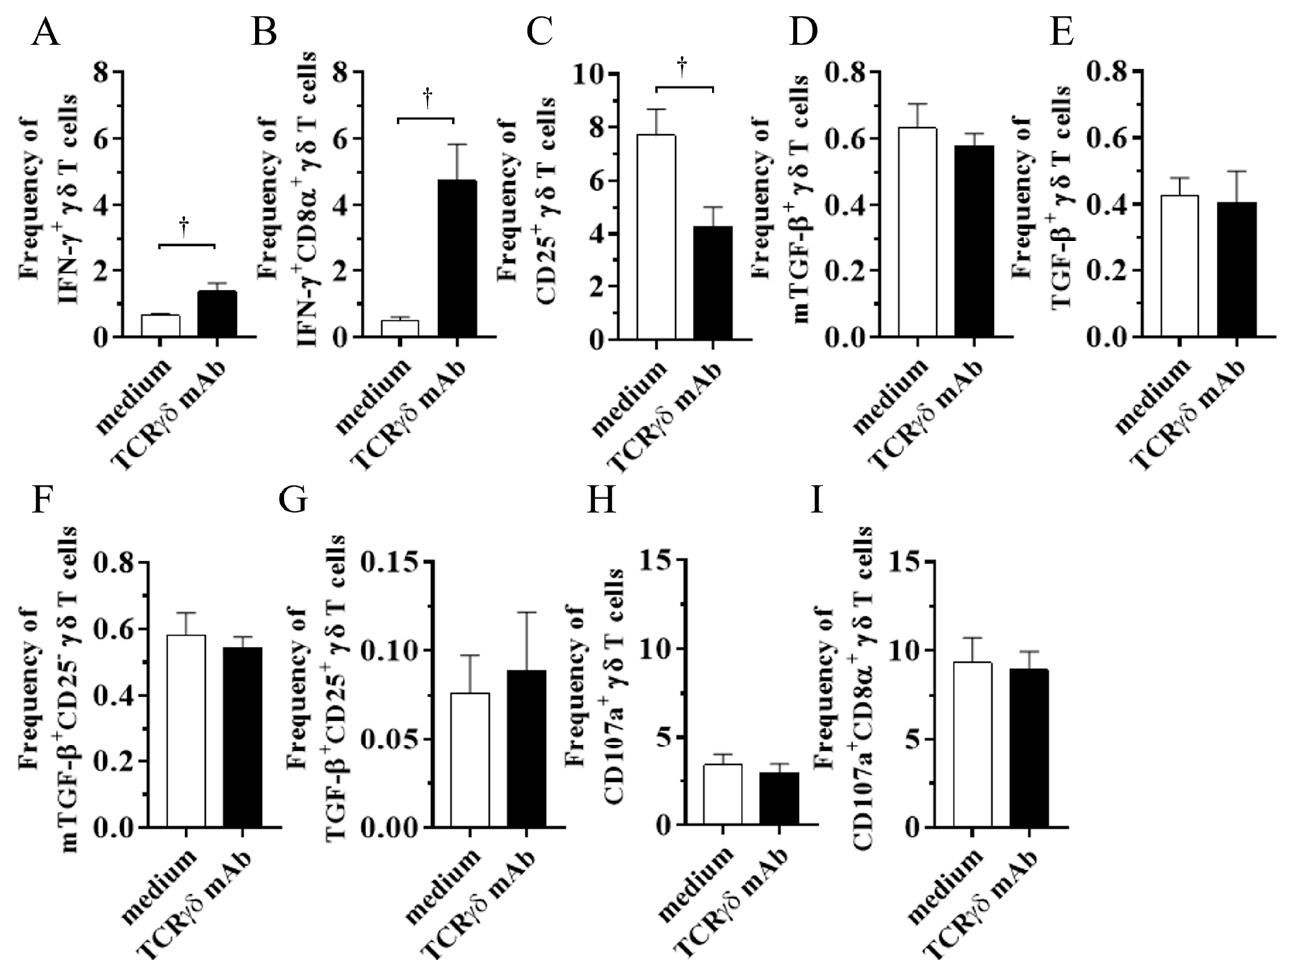
Figure 1. Cytokine and CD107a profiles in γδ T cells at 4 or 18 h post-stimulation with anti-TCR γδ antibody. The PBMCs obtained from healthy SPF chickens were stimulated with or without anti- TCR γδ antibody, and degranulation activity of γδ T cells (4 h post-stimulation (hps)) and cytokine production (18 hps) were analyzed using flow cytometry. Percentages of IFN- γ + γδ T cells within γδ T cell populations ( A ), IFN- γ + CD8 α + γδ T cells within CD8 α + γδ T cell populations ( B ), CD25 + γδ T cells within γδ T cell populations ( C ), mTGF- β γδ T cells within γδ T cell populations ( D ), TGF- β γδ T cells within γδ T cell populations ( E ), mTGF- β + CD25 - γδ T cells within γδ T cell populations ( F ), TGF- β + CD25 + γδ T cells within γδ T cell populations ( G ), CD107a + γδ T cells within γδ T cell populations ( H ), and CD107a + CD8 α + γδ T cells within CD8 α + γδ T cell populations ( I ) derived from the PBMCs are shown. TCR γδ -unstimulated cells were used as a negative control. Data represent the mean of 6 biological replicates ± SE. Significant differences are indicated by †: p <